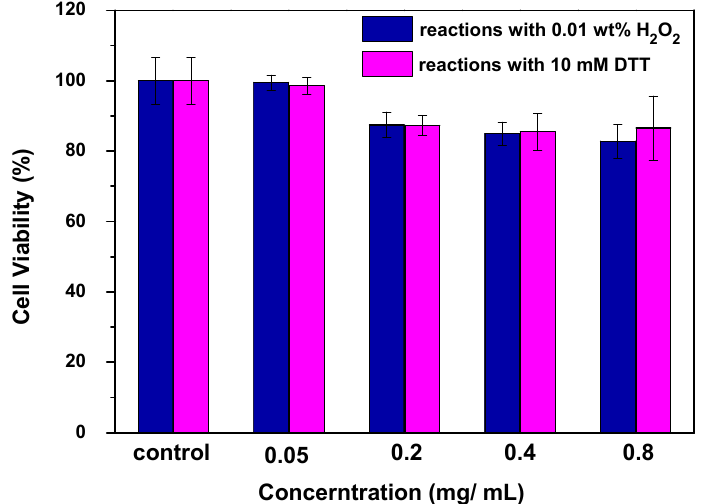
Figure 5. Cytotoxicity of SeSe 0.01 -PAA-TPE 0.02 after the reactions with 0.01 wt.% H 2 O 2 or 10 mM DTT against HeLa cells at various concentrations.